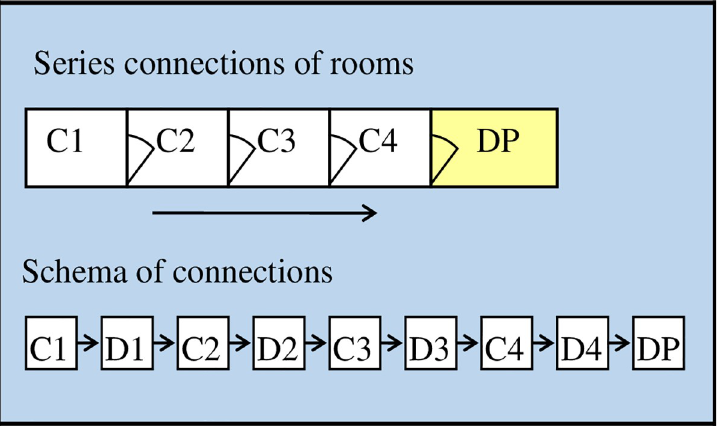
Fig 3. Series connections of rooms and their schema. C- corridors, D- doors, DP-destination point.